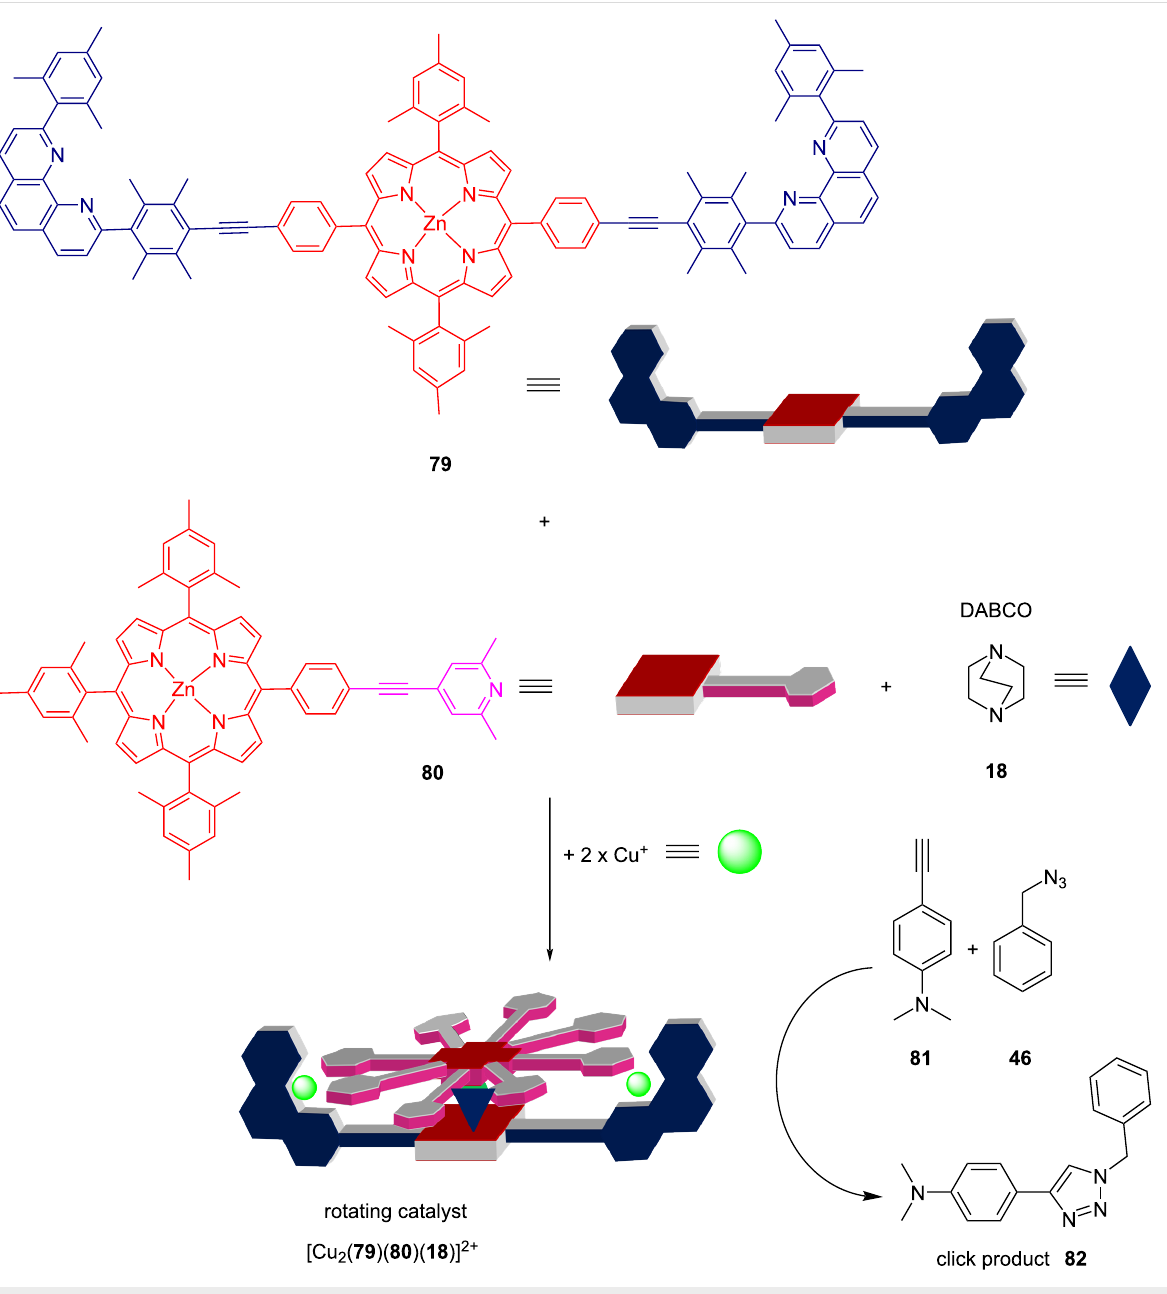
Figure 22: Four-component nanorotor and its catalytic activity. Adapted with permission from (Biswas, P. K.; Saha, S.; Gaikwad, S.; Schmittel, M. J. Am. Chem. Soc. 2020, 142, 7889–7897 [77]). Copyright (2020) American Chemical Society.